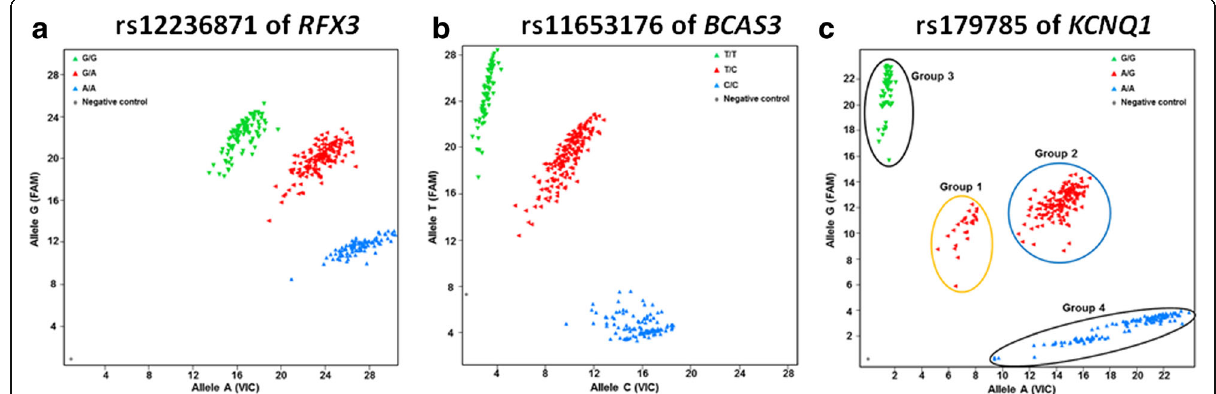
Fig. 1 Allelic discrimination plots of SNPs of RFX2 , BCAS3 and KCNQ1 . a Representative plots for rs12236871 of RFX3 . Well-separated clusters representing each genotype (G/G, G/A and A/A) can be observed. b Representative plots of rs11653176 of BCAS3 . Well-separated clusters are clearly visible, representing each genotype (T/T, T/C and C/C). c Representative plots of rs179785 of KCNQ1 . Computer auto analysis divided these plots into three groups (G/G, A/G and A/A). However, the plots seemed to be clustered into four groups (labeled as Groups 1 to 4). We therefore employed direct sequencing to confirm the genotypes. As a result, a 12-bp deletion variant of KCNQ1 (rs200562977) was identified in several samples of all of four groups, and rs179785 of KCNQ1 is located at the last nucleotide of this deletion variant (also see Figs. 2 and 3). Therefore, because it is difficult to genotype rs179785 using the TaqMan method, we performed the subsequent genotyping of rs179785 and rs200562977 by direct